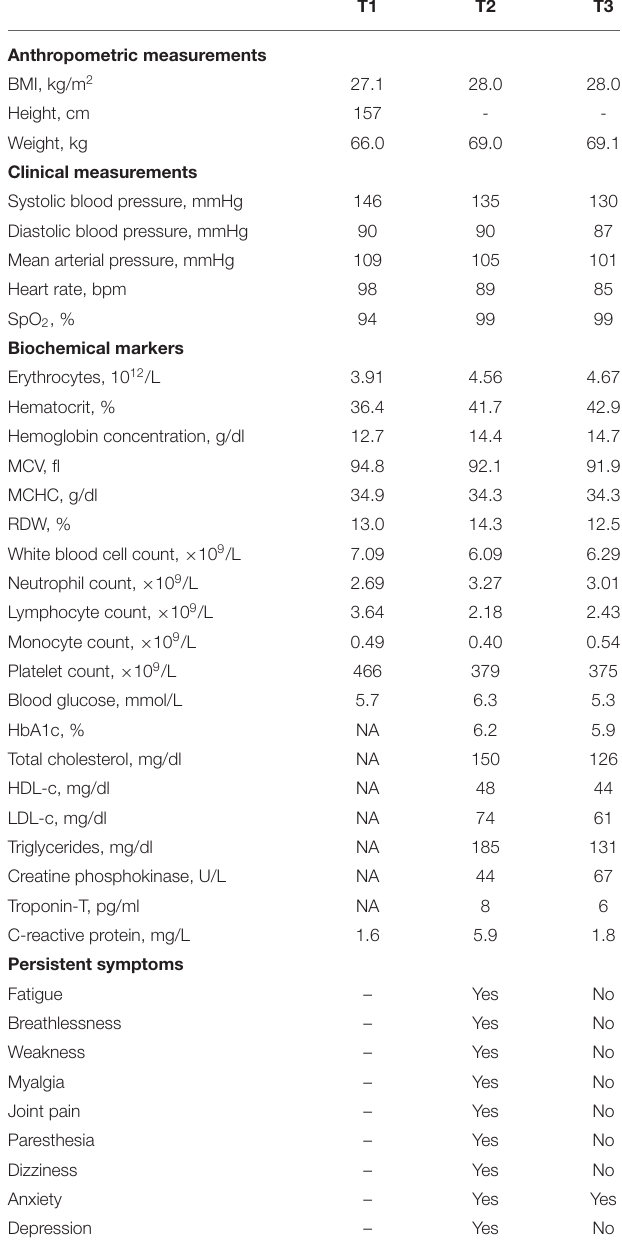
TABLE 1 | Patient’s physical, clinical, and laboratorial parameters.